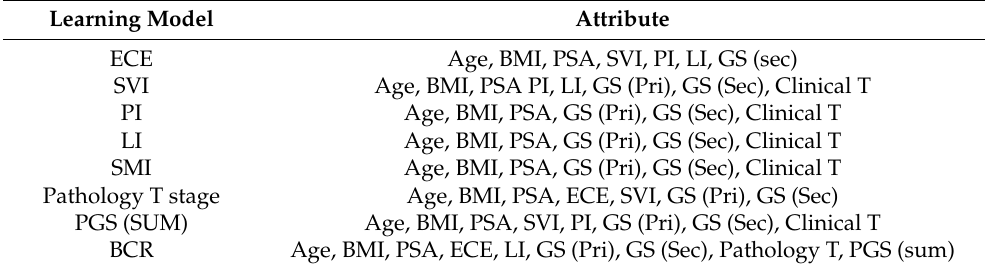
Figure 7. Digital-twin-based prediction model. Table 2. Learning model and attribute.